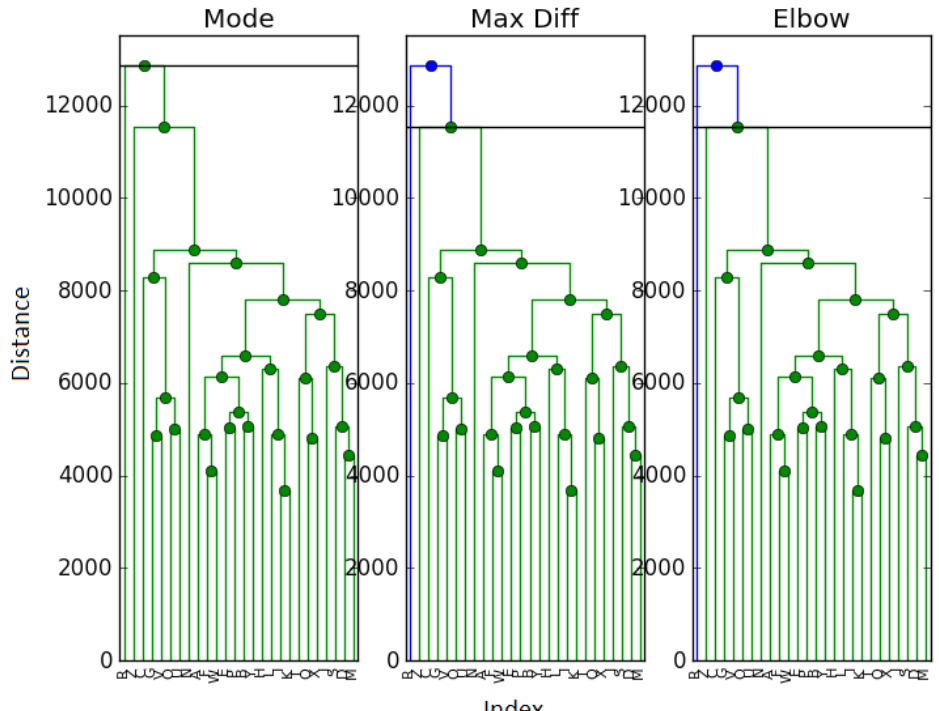
Figure 6. Clustering of the ExpressionSet with mixing.